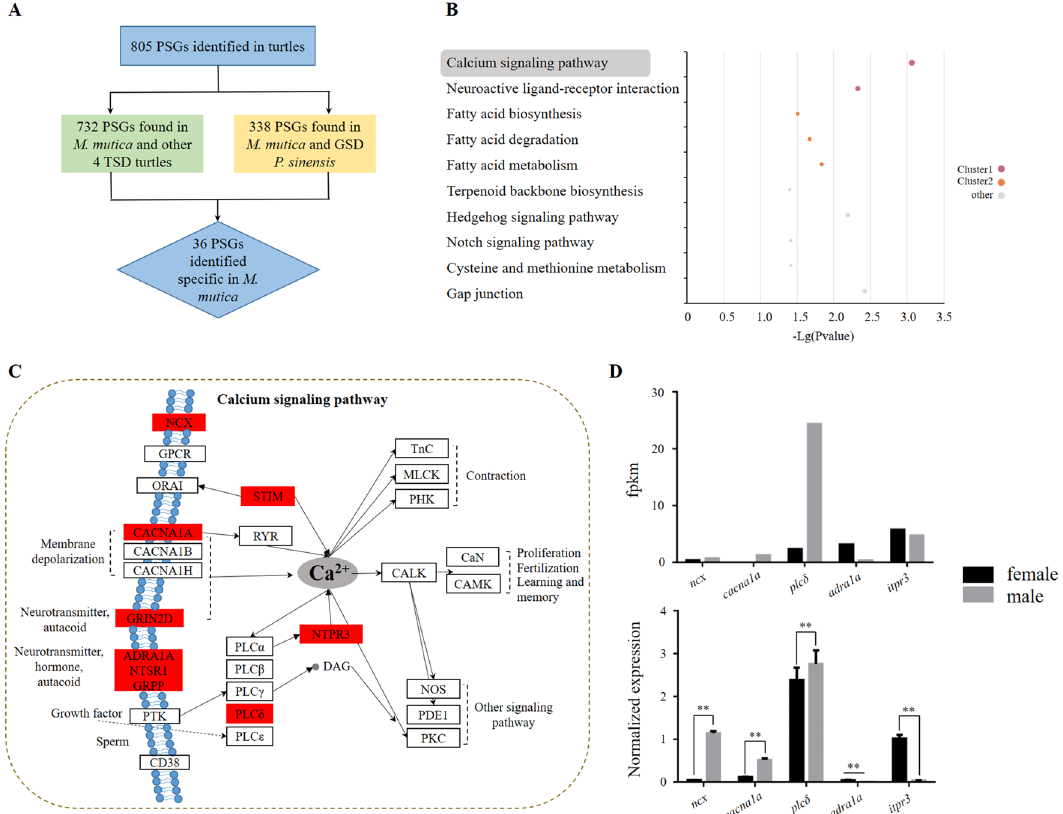
Figure 5. Positively selected genes and their enriched KEGG pathways in Asian yellow pond turtles. ( A ) Number of positively selected genes identified in 6 turtles (5 temperature-dependent sex determination turtles, C . picta , T. scripta , C . mydas , P . megacephalum , M. mutica , and one genotypic sex determination, P. sinensis ). ( B ) Top 10 enriched KEGG signaling pathways of 455 TSD turtle-specific positively selected genes. ( C ) Calcium signaling pathway. The genes in the red box indicate those were positively selected. ( D ) Expression levels of positive selection genes in the calcium signaling pathway between testis and ovaries of M. mutica . The black and gray boxes represent the expression level in the testis and ovaries, respectively. *, p < 0.05; **, p <